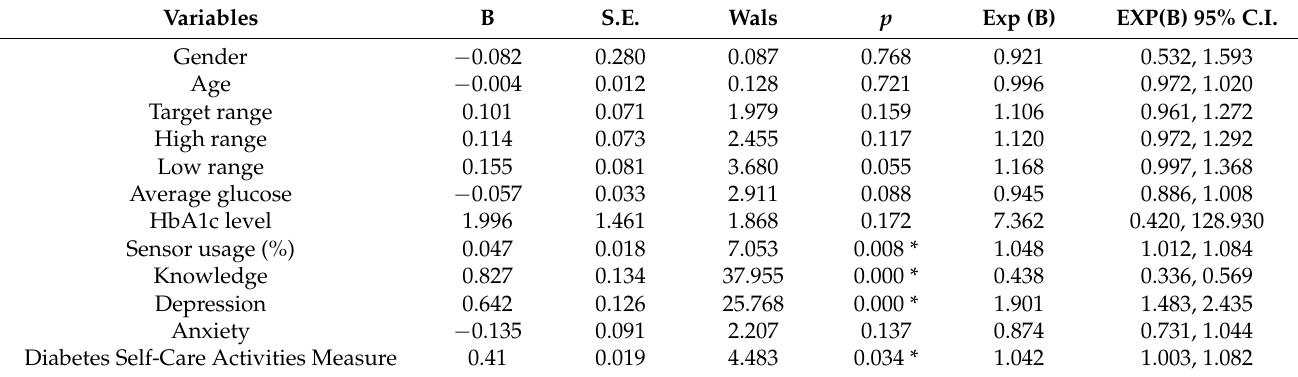
Table 5. Factors of two groups through a Binary Logistic